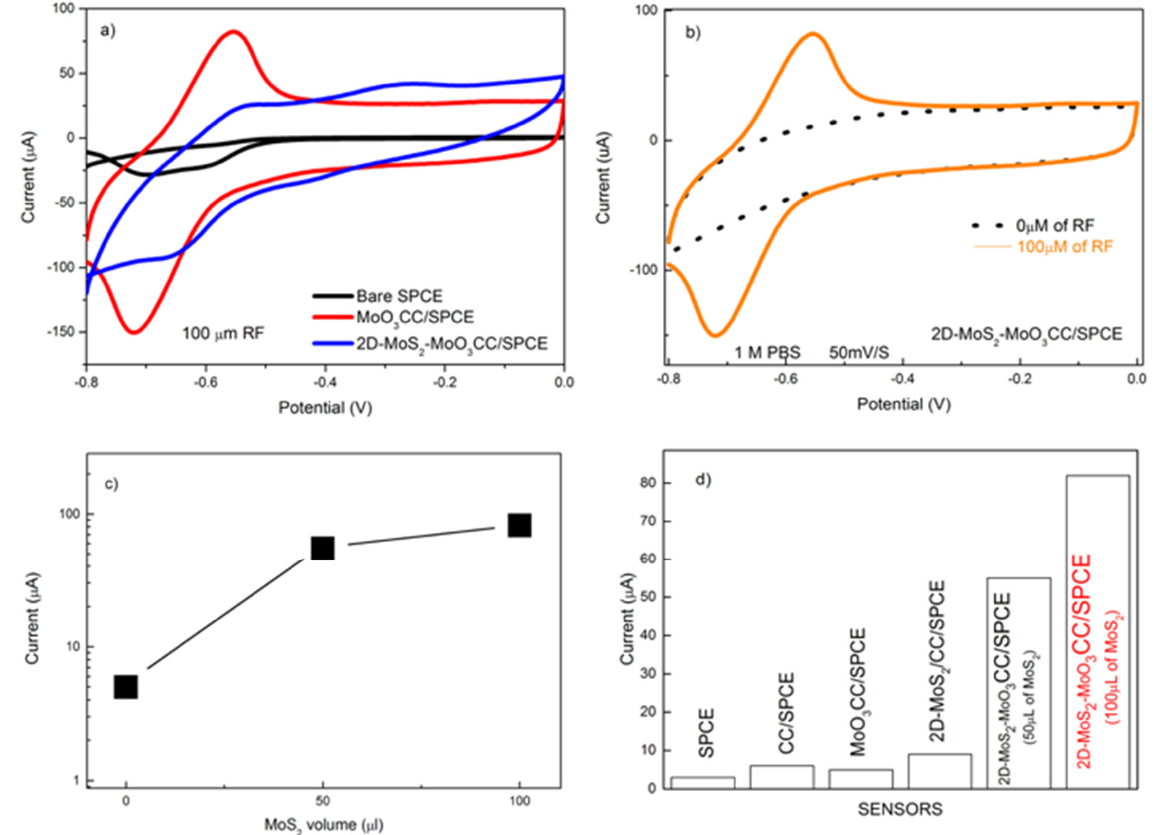
Figure 7. ( a ) CV of the bare SPCE (black line), MoO 3 CC/SPCE (blue line) and 2D-MoS 2 -MoO 3 CC/SPCE (red line) in presence of 100 µ M RF; ( b ) CV of 2D-MoS 2 -MoO 3 CC/SPCE in absence (black dotted line) and in presence of 100 µ M RF (orange line);( c ) Ipa current vs. the volume of 2D-MoS 2 nanosheets suspension used for the MoO 3 CC matrix modification; ( d ) comparison of the Ipa current obtained with the different electrodes in presence of 100 µ M riboflavin (RF).